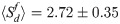
The average sharing number 〈Sd〉 as a function of U for females (red) and males (blue).Females: 〈Sd〉 evaluated at Uff = 0.82 gives 〈Sdf〉=2.72±0.35 (indicated by the red-rectangle) and the experimental value is S¯df=2.7±0.56 (dotted-magenta). Males: 〈Sd〉 evaluated at Umm = 3.45 gives 〈Sdm〉=0.60±0.30 (blue-rectangle) and the experimental value is S¯dm=0.6±0.44 (dotted-cyan).